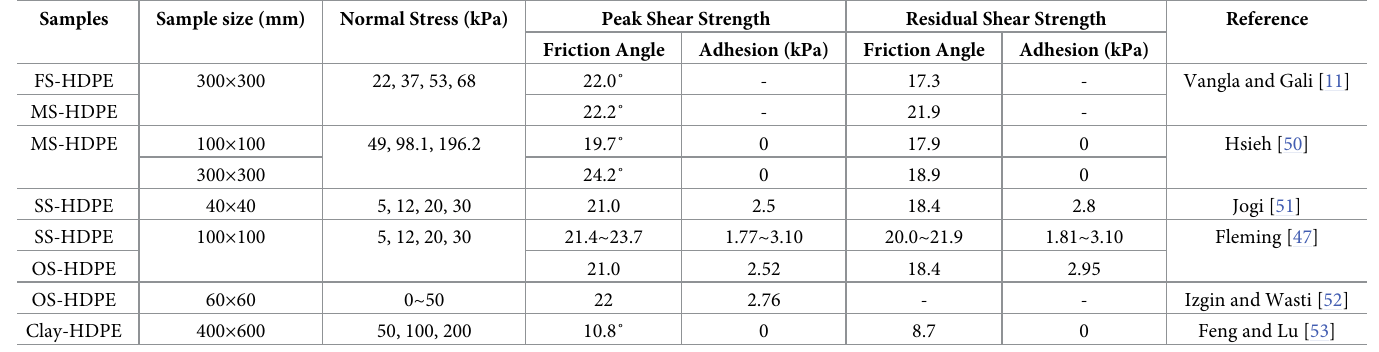
Table 5. Summary of similar tests for the selected HDPE-sand/soil interfaces.